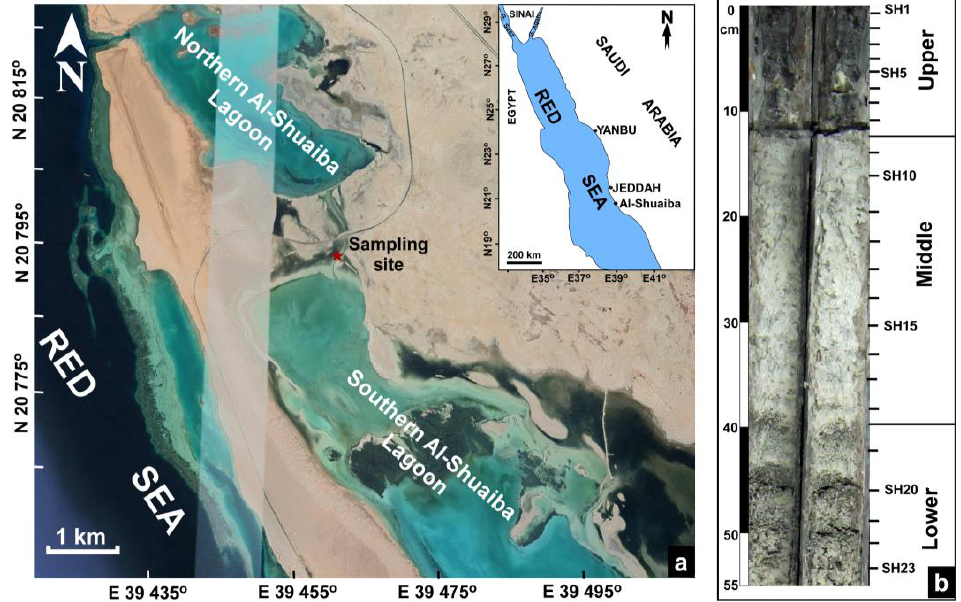
Figure 1. Location map of the area of study ( a ) and the core sample ( b ). Most of the previous studies in the Al-Shuaiba area were carried out on the southern Al-Shuaiba Lagoon bottom sediments and the shallow subsurface sediments of the tidal flat to the east. The effect of meteorological forcing and tide on the flushing of Al-Shuaiba Lagoon was studied by Ahmad and Sultan [28] and Al-Barakati [29]. The mineralogical